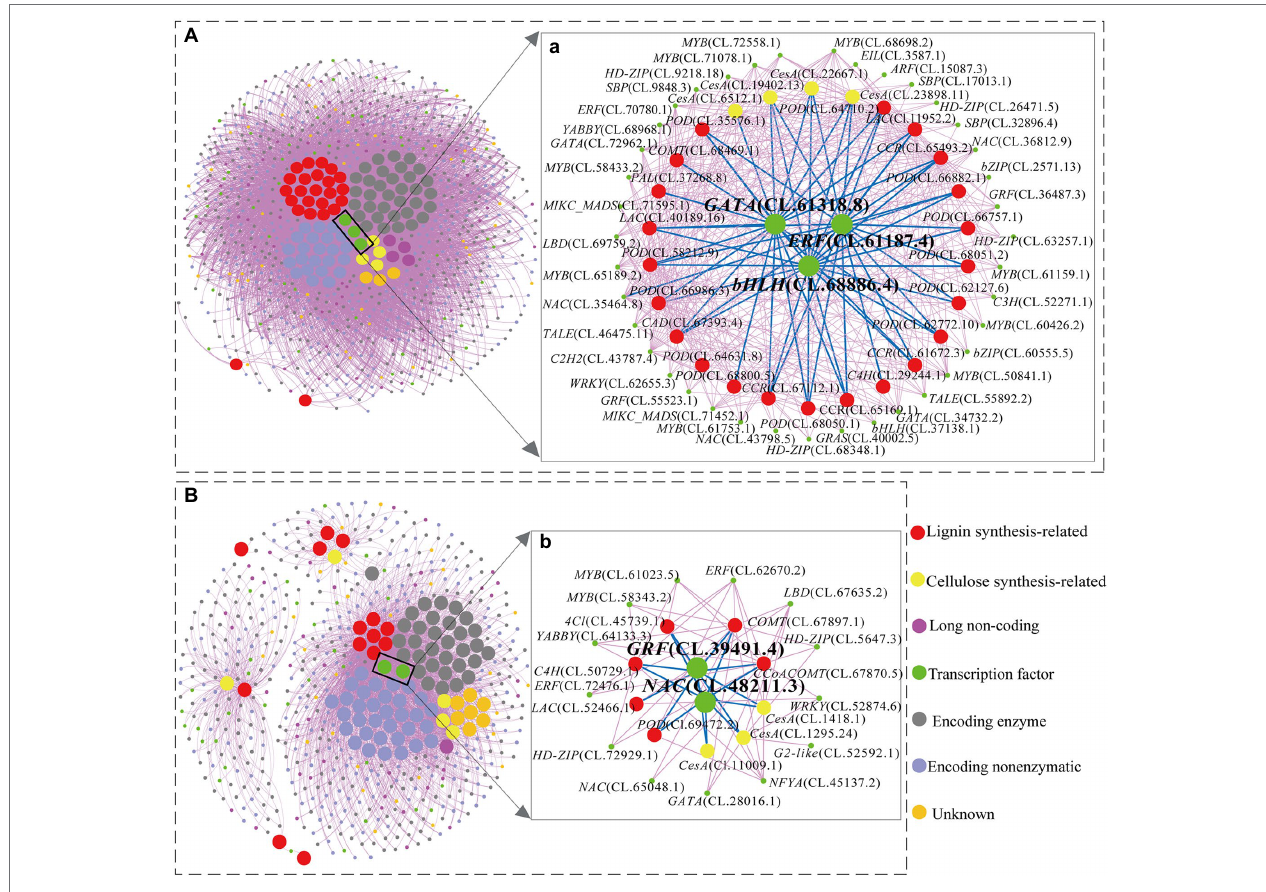
FIGURE 5 | The genes regulatory network associated with cellulose and lignin biosynthesis in red (A) and pink (B) modules. (a): The directly and indirectly connected genes to the three hub TFs in red modules. (b): The directly and indirectly connected genes to the two hub TFs in pink